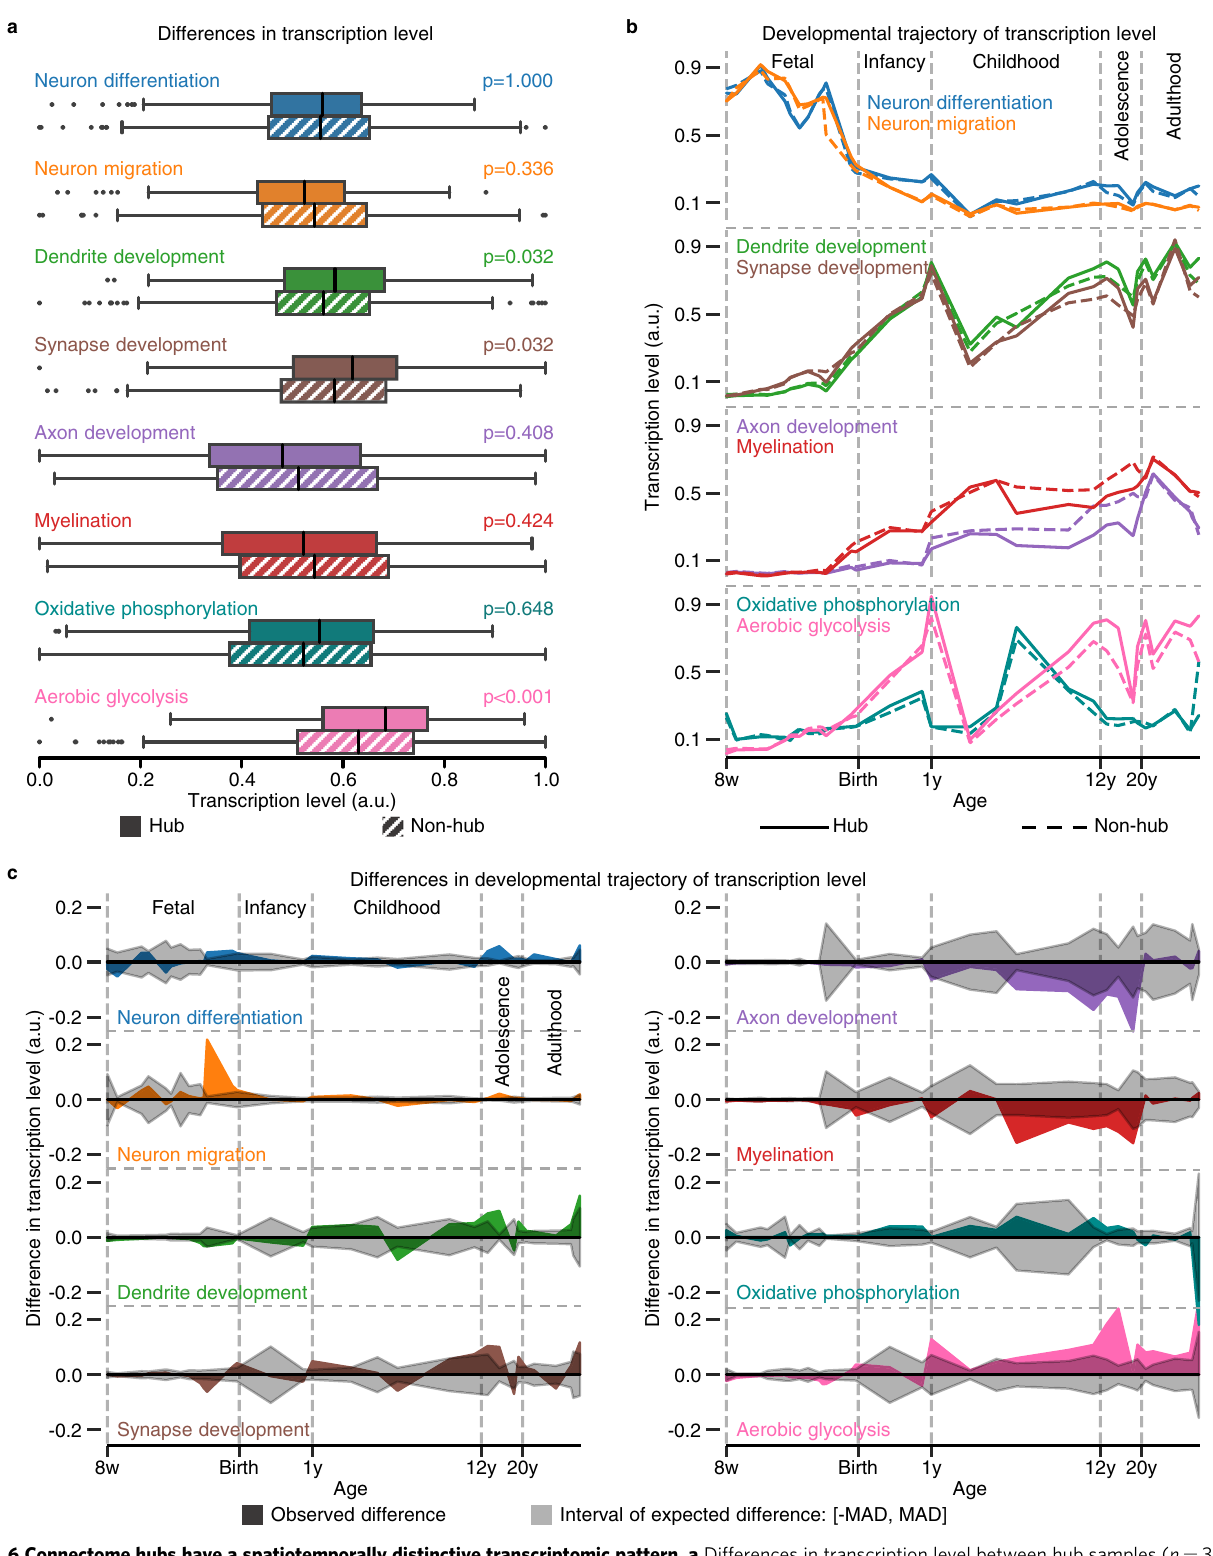
Fig. 6 Connectome hubs have a spatiotemporally distinctive transcriptomic pattern. a Differences in transcription level between hub samples ( n = 382) and non-hub samples ( n = 776) for genes associated with key neurodevelopmental processes 38 and main neuronal metabolic pathways 39 . Boxplot left and right edges, vertical black lines, and whiskers and dots depict the 25th and 75th percentiles, median, and extreme nonoutlier and outlier values, respectively. The statistical signi fi cances of one-sided Wilcoxon rank-sum tests were determined by 1000 permutation tests and were labeled with Bonferroni-corrected p values. b Developmental trajectory of transcription level in hub and non-hub regions for genes involved in key neurodevelopmental processe 38 and main neuronal metabolic pathways 39 . c Differences in the developmental trajectory of transcription level between hub and non-hub regions shown in b . MAD, the median absolute deviation of transcription level across brain regions. w post-conceptional week, y postnatal year, a.u. arbitrary